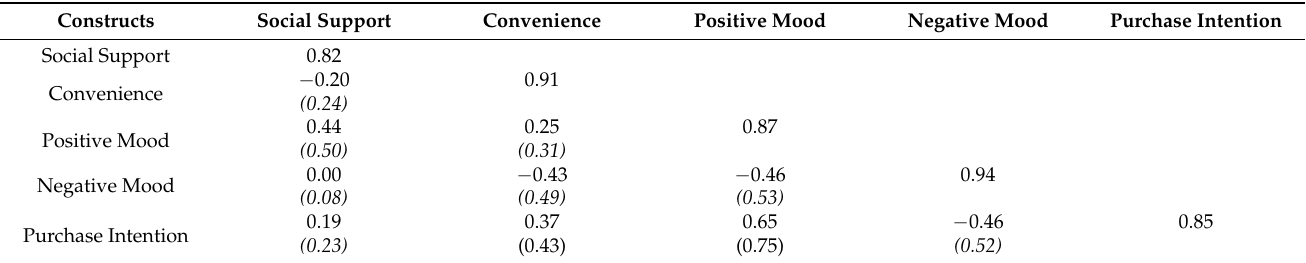
Table A4. Discriminant validity results for Extraversion group.